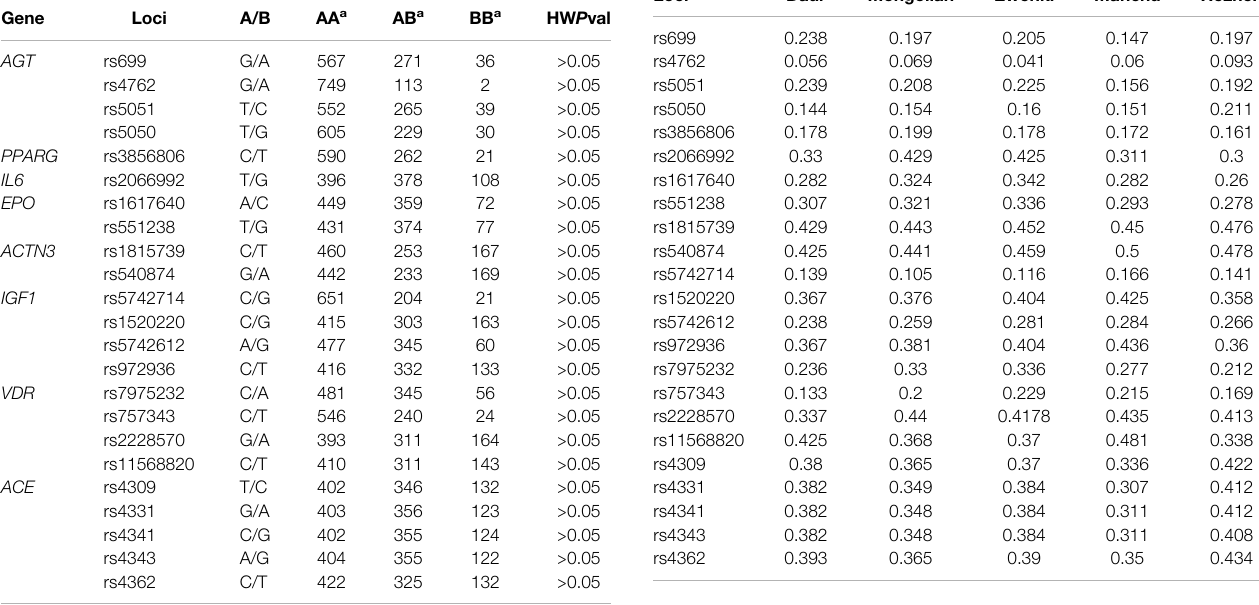
TABLE 1 | The genotype distribution and Hardy-Weinberg equilibrium test for the 23 SNPs in fi ve ethnic populations from China. Gene